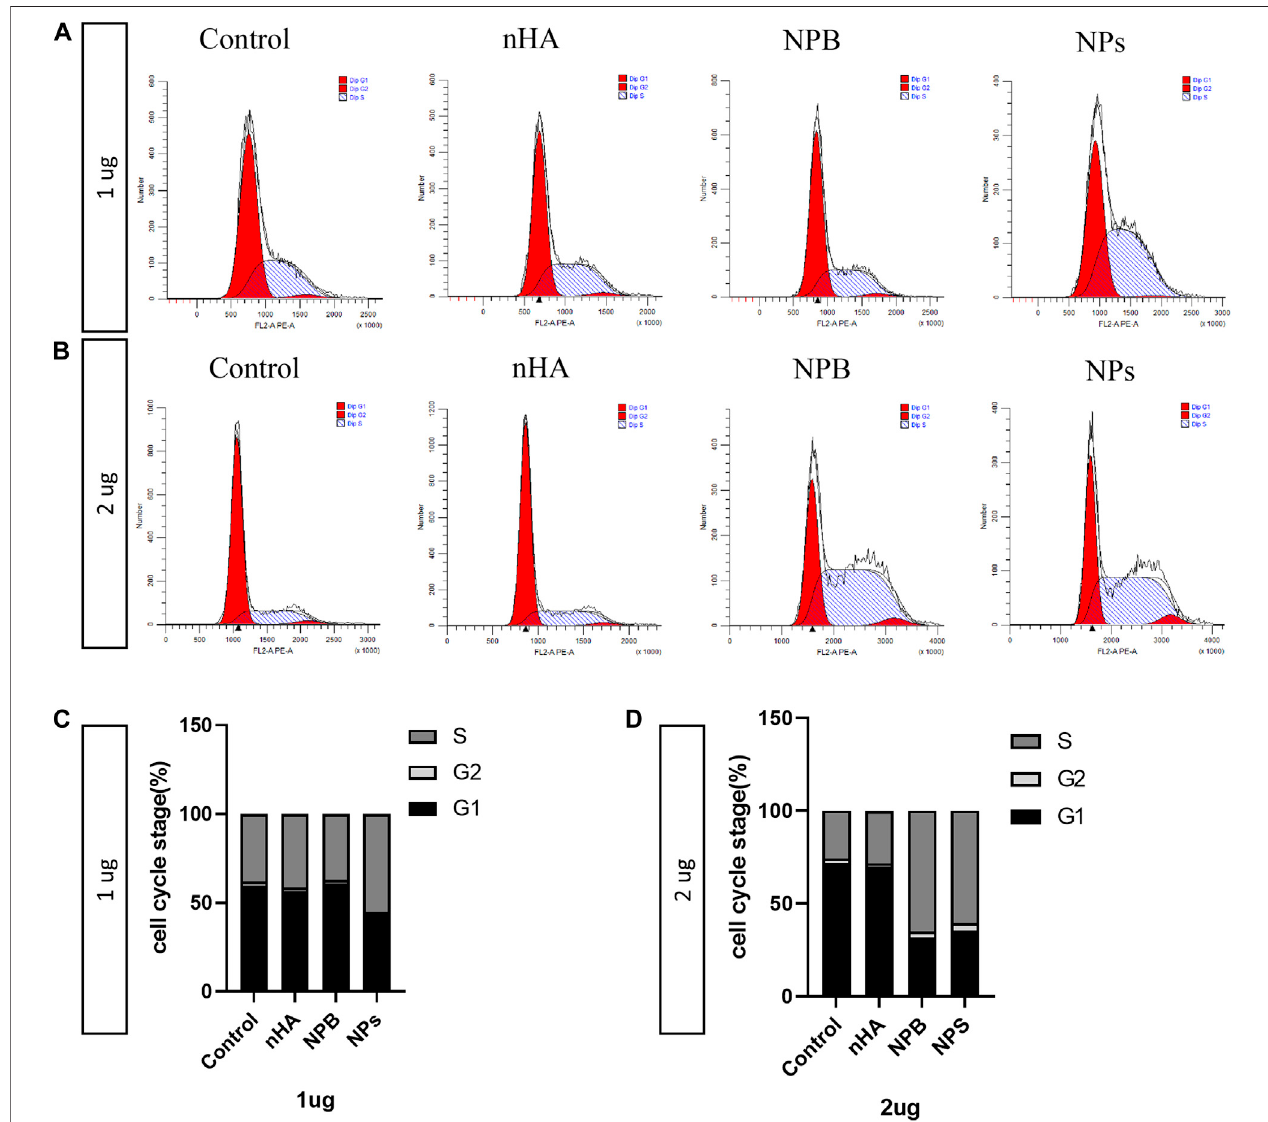
FIGURE 4 | Nanoparticles affect the cell cycle of osteosarcoma. (A) Cell cycle results of 143b cells treated with 1 μ g/ml of nanoparticles. (B) Cell cycle results of 143b cells treated with 2 μ g/ml of nanoparticles. (C) Distribution of the cell cycle stages of 143b cells treated with 1 μ g/ml nanoparticles. (D) Distribution of cell cycle stages of 143b cells treated with 2 μ g/ml